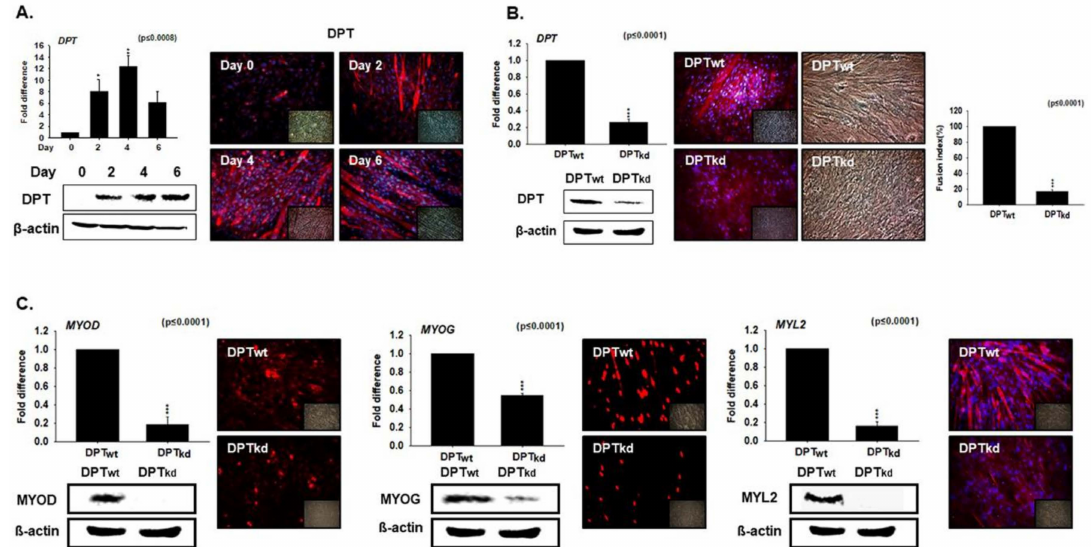
Figure 2. The e ff ect of switching cells from proliferation to di ff erentiation on DPT expression, and DPT expression during myoblast di ff erentiation. ( A ) C2C12 cells were cultured with 2% FBS for 0, 2, 4, and 6 days. The relative DPT mRNA level was assessed by real-time RT-PCR, and protein expression was evaluated by Western blot and immunocytochemistry. ( B ) DPT knock-down was performed and cells were cultured with 2% FBS for 4 days. Myotube formation and fusion index were evaluated by Giemsa staining, DPT mRNA expression by real-time RT-PCR, and protein expression by Western blot and immunocytochemistry. ( C ) mRNA expression by real-time RT-PCR and protein expression by Western blot and immunocytochemistry in DPT kd and DPT wt cells. DPT wt indicates cells transfected with